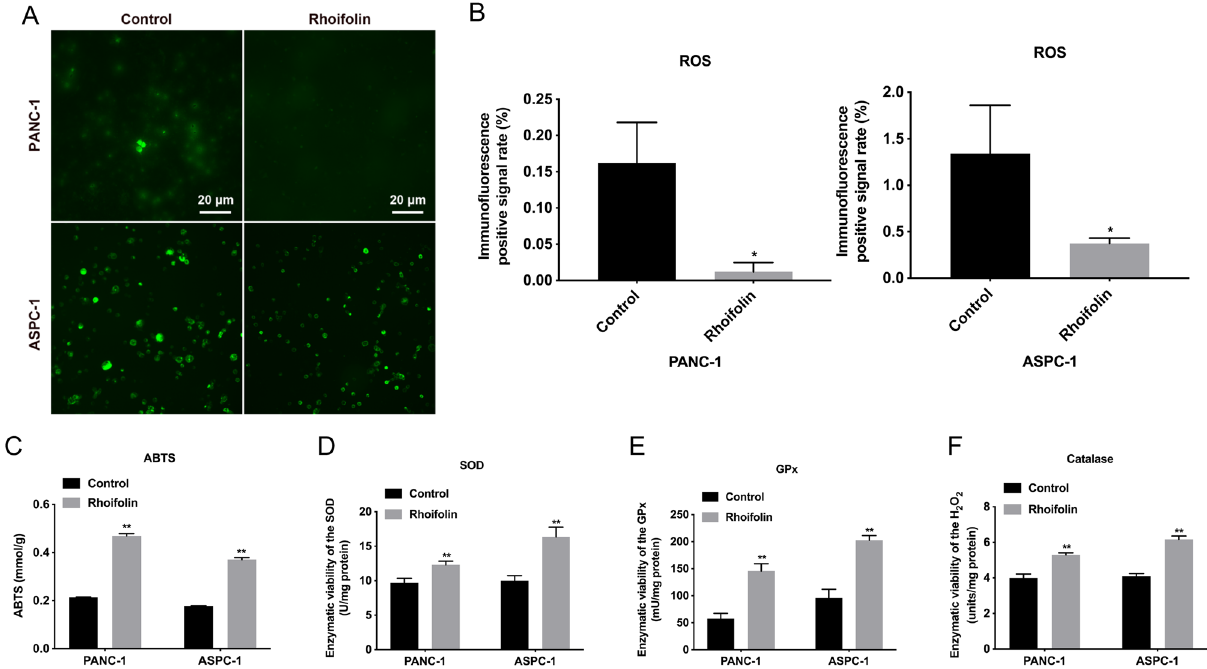
Figure 2. Rhoifolin enhanced the antioxidant capacity of pancreatic cancer cells. (A) The level of ROS was tested with ROS examination kit in PANC-1 and ASPC-1 cells disposed of rhoifolin. (B) And the immunofluorescence positive rate was calculated. (C) ABTS kit was also applied to examine antioxidant capacity of PANC-1 and ASPC-1 cells treated with or without rhoifolin. The levels of SOD (D) , GPx (E) , and catalase (F) were confirmed using the corresponding kits in PANC-1 and ASPC-1 cells after rhoifolin